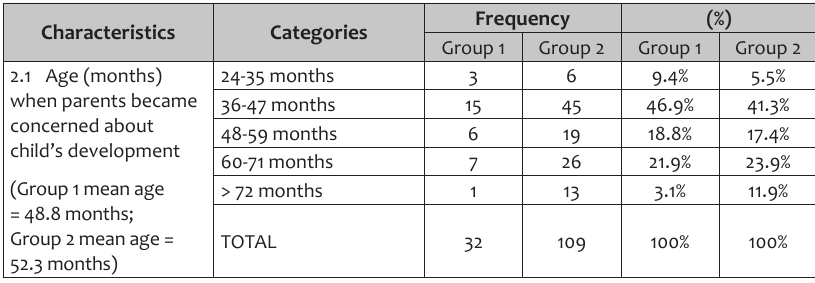
Table 2: Comparison of participant profiles between Group 1 (n=32) and Group 2 (n=109)